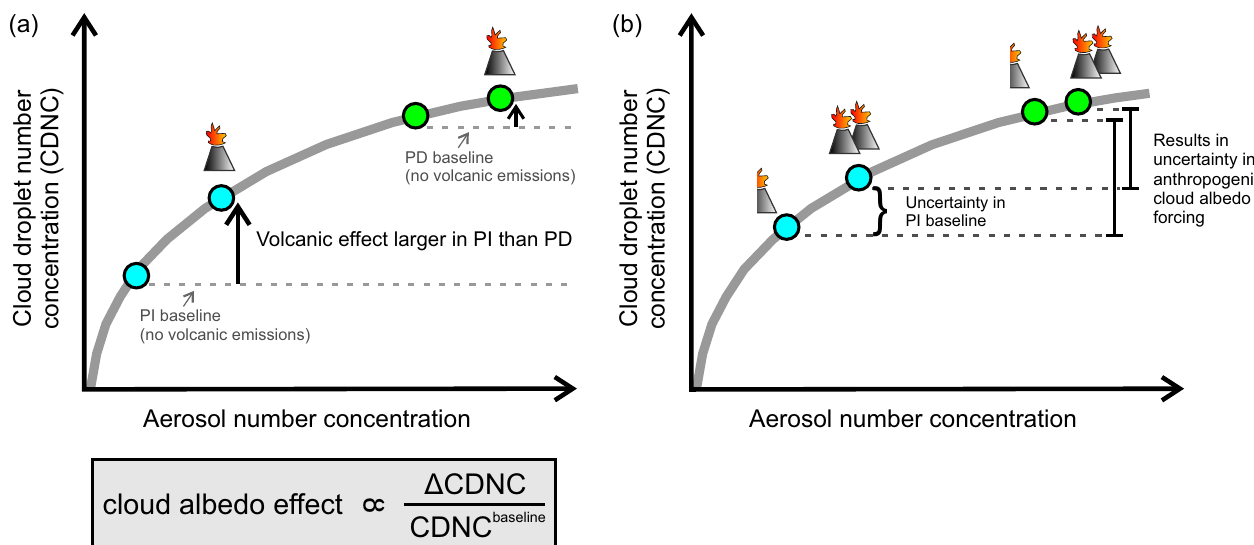
Fig. 5. Relationship between aerosol number concentration and cloud droplet number concentration (CDNC) with (a) showing that the volcanically induced cloud albedo effect is larger under pre-industrial (PI) atmospheric conditions (blue circles) than under present-day (PD) conditions (green circles) because of the greater relative change in CDNC ( 1 CDNC/CDNC baseline with 1 CDNC = CDNC with volcanics − CDNC baseline ) under PI conditions; and (b) showing the effect of the uncertainty in the PI baseline, which arises from the − 50%/ + 100% uncertainty in the volcanic flux strength, on the magnitude of the anthropogenic cloud albedo forcing.